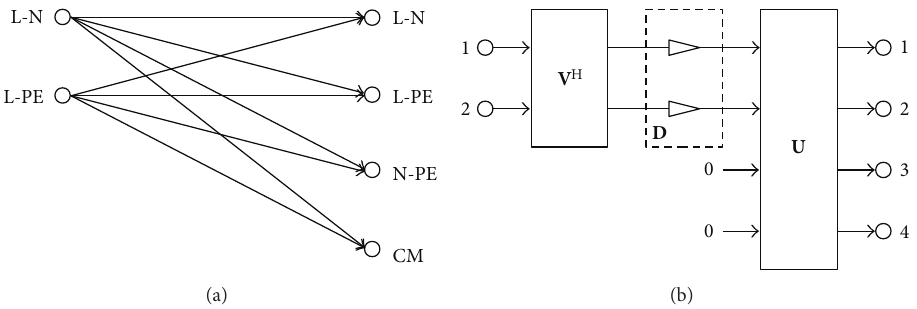
Figure 4: Schematic MIMO channel and decomposition into parallel and independent MIMO streams.